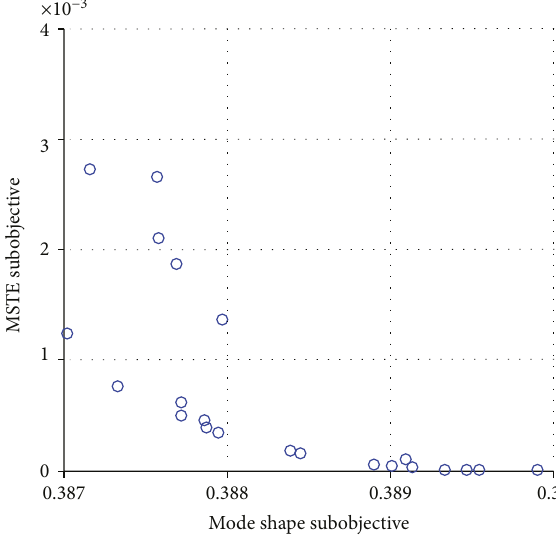
Figure 6: Optimal front obtained from MOLFPSO/TOPSIS in damage scenario 1 under noisy